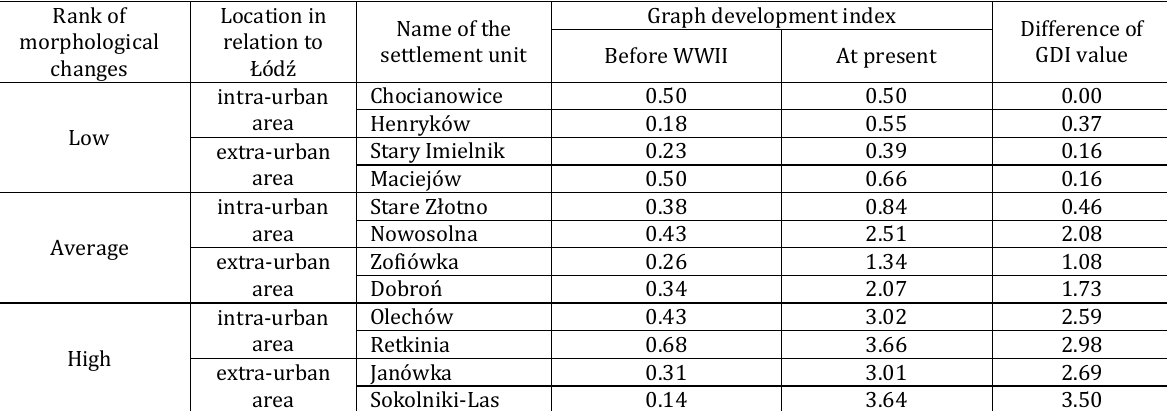
Table 3. Changes in the degree of development of graphs of the surveyed units in the inter-war and contemporary